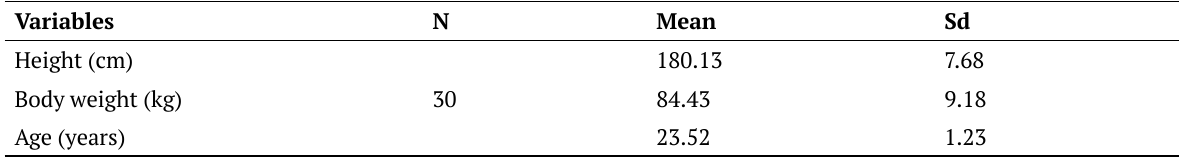
Table 1. Descriptive statistics of participants